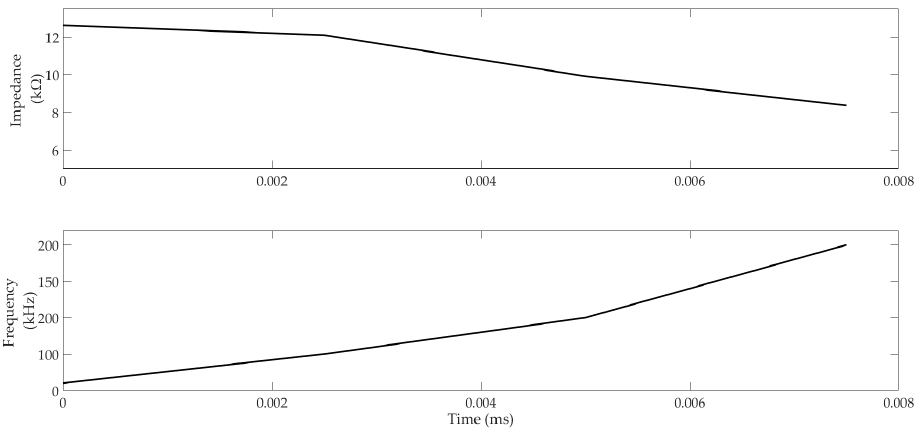
Figure 6. Control sample impedance sampling for modeling in a complex variable.